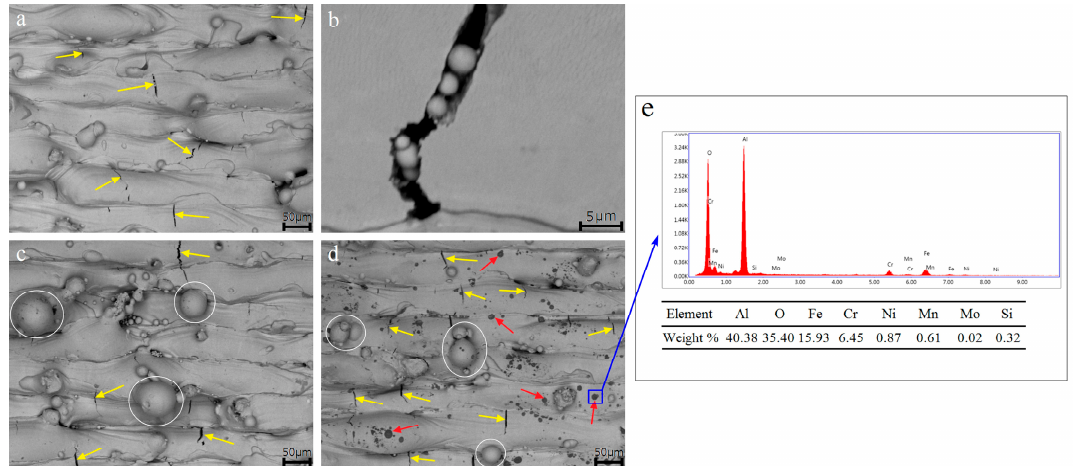
Figure 4. SEM images of top surface of three SLM SS316L samples ( a ) low and ( b ) high magnification of a crack containing un-melted particles of fine powder, ( c ) coarse powder, ( d ) raw powder and ( e ) microanalysis of the non-metals substances in ( d ).